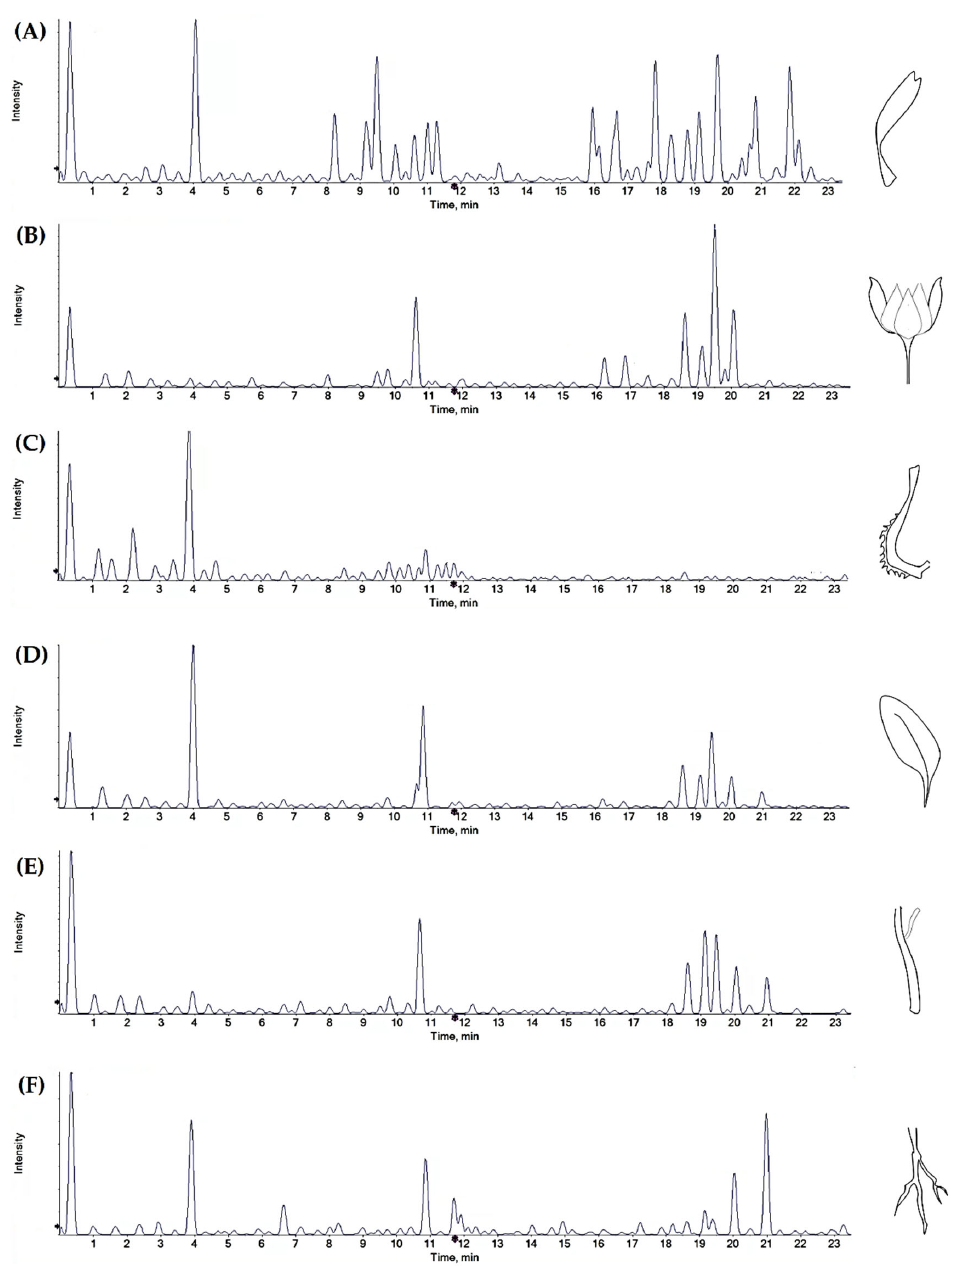
Figure 2. TICs (Total Ion Chromatograms) of the alcoholic extracts from ( A ) florets, ( B ) bracts, ( C ) fruits, ( D ) leaves, ( E ) stems, and ( F ) roots of Calendula arvensis .